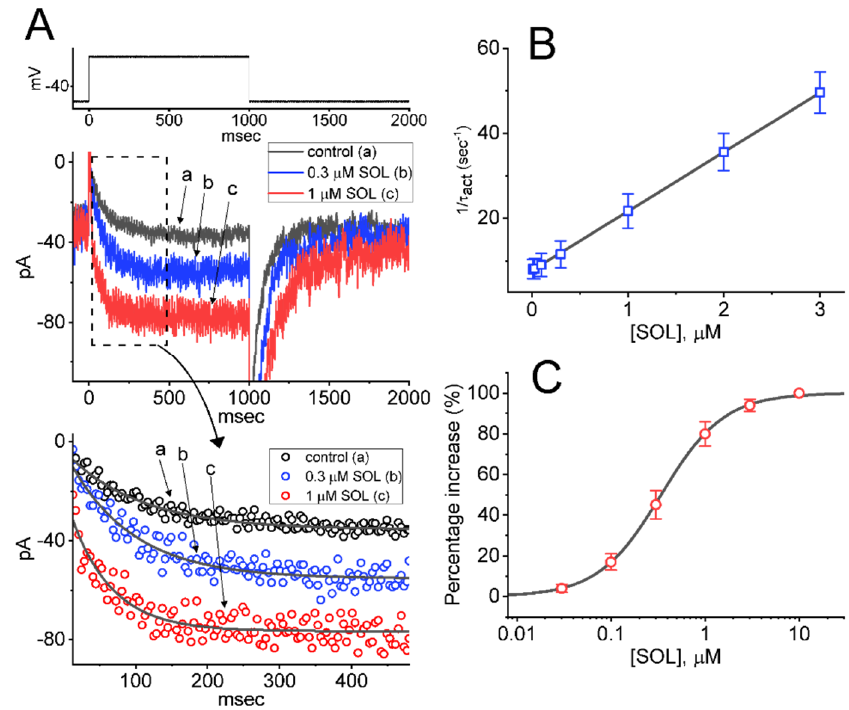
Figure 3. Effect of SOL on I K(M) recorded from GH 3 cells. This set of experiments was undertaken in cells which was kept bathed in high − K + , Ca 2+ − free solution containing 1 µ M TTX and 0.5 mM CdCl 2 , and we backfilled the recording electrode by using K + − containing (145 mM) solution. ( A ) Representative I K(M) traces obtained in the control period (i.e., SOL was not present; a) and during cell exposure to 0.3 µ M SOL (b) or 1 µ M SOL (c). The uppermost part denotes the voltage − clamp protocol applied, while the lower part shows the activation time courses of I K(M) taken in the absence (a) and presence of 0.3 µ M SOL (b) or 1 µ M SOL (c). Current traces in the bottom panel show an expanded record from the dashed box in the top panel, and their trajectories taken from (A) was well fitted by a single exponential (indicated in smooth gray line). Data points (indicated in open circles) with or without the addition of SOL are reduced by 20. ( B ) Kinetic estimate of SOL − stimulated I K(M) identified in GH 3 cells (mean ± SEM; n = 8 for each point). The reciprocal of activation time constant of I K(M) (1/ τ act ) derived from exponential fit of the I K(M) trajectory was collated and linearly plotted against the SOL concentration (gray straight line). Forward ( k ∗ + ) or backward ( k − 1 ) rate constant for the binding scheme, derived from the slope and the y − axis of the interpolated line was estimated to be 13.962 sec − 1 µ M − 1 or 7.672 sec − 1 , respectively; thereafter, the K D value ( k − 1 / k ∗ + = 0.55 µ M) was yielded. ( C ) Concentration − dependent relationship of SOL effect on I K(M) activated by 1 − sec long membrane depolarization (mean ± SEM; n = 8 for each point). Current amplitude was measured at the end − pulse of each depolarizing step from − 50 to − 10 mV with a duration of 1 sec. The sigmoidal curve (gray line) indicates the goodness of fit to the Hill equation, as stated in Materials and